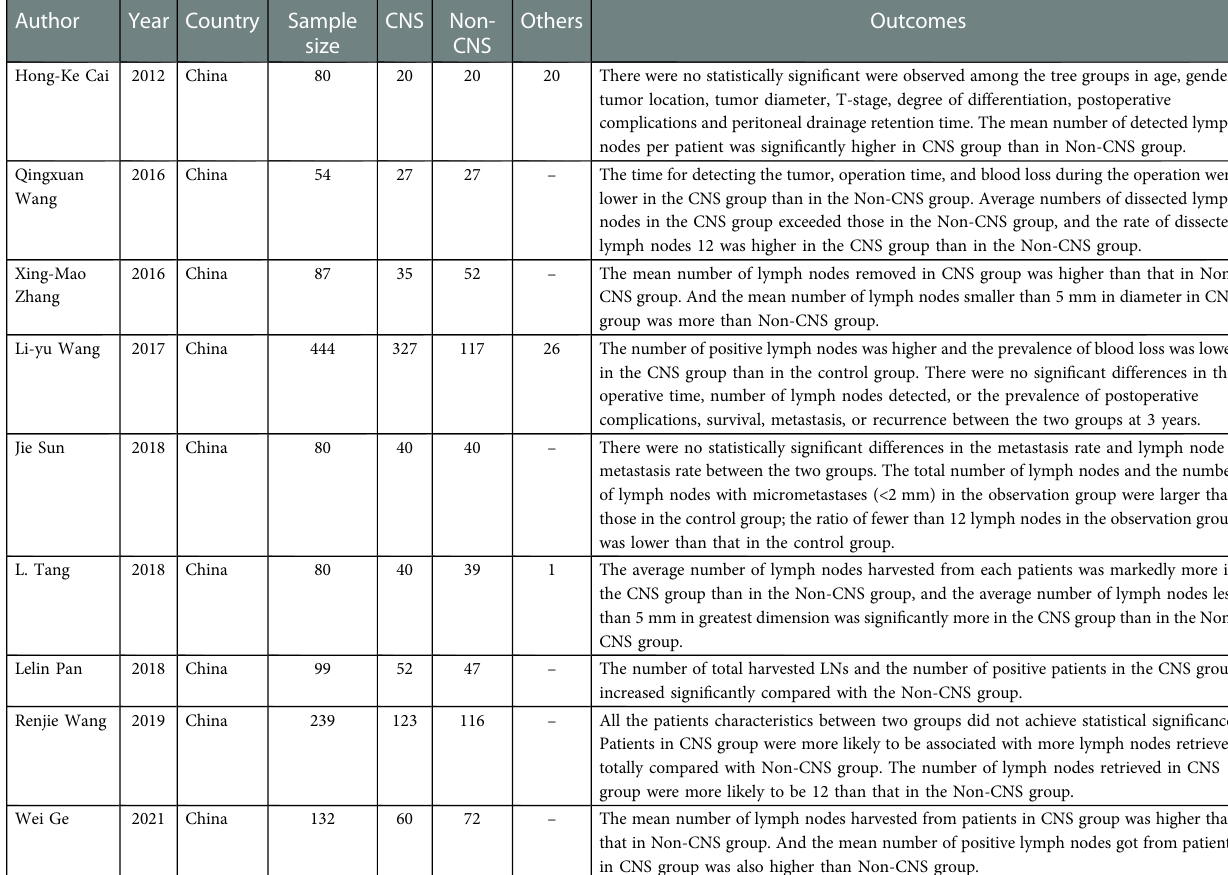
TABLE 4 The difference between CNS and Non-CNS group were reported from previous